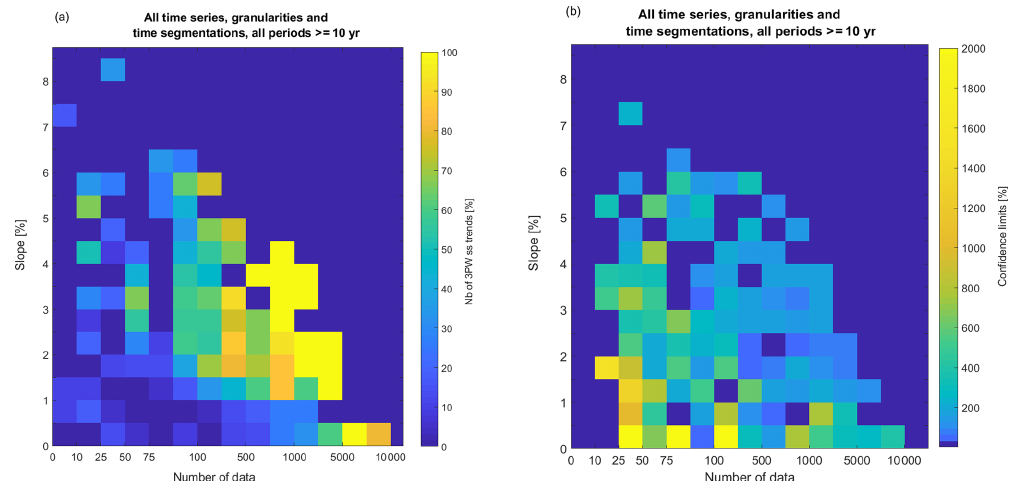
Figure 11. (a) The percentage of 3PW ss trends (Sect. 2.3) and (b) mean confidence limits normalized by the slope as a function of slope normalized by the median and N categories for all time series, granularities and time segmentations and all periods of at least a decade. The slopes are binned regularly (bin size = 0 . 5%), but N categories are irregular. Cells with fewer than three results were discarded in panel (a) .